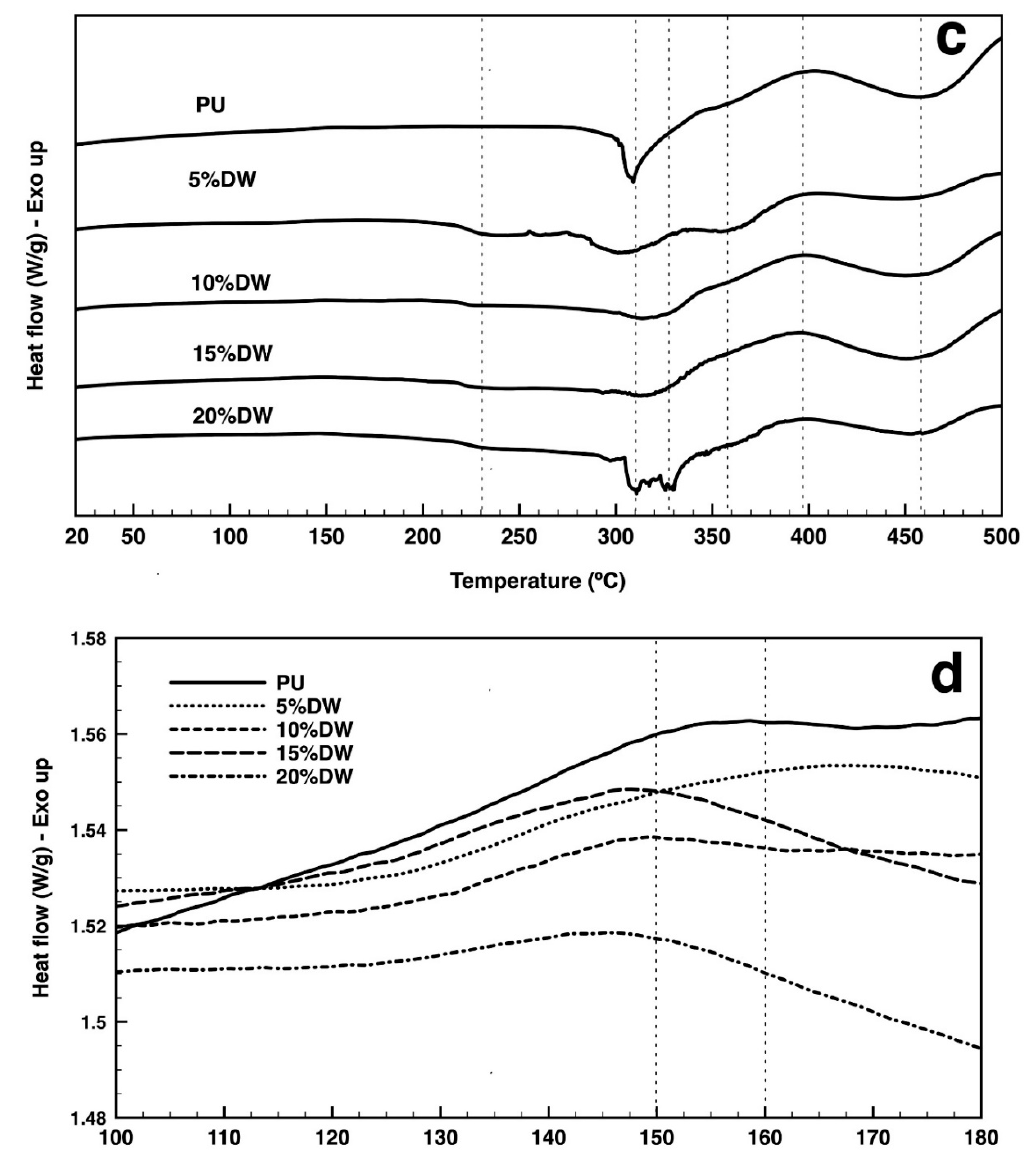
Figure 6. DSC thermogram of the pristine PU and the eco-composites containing 5, 10, 15, and 20% of dog wool microparticles collected at a heating rate of 10 ◦ C / min in a nitrogen atmosphere. ( a ) The first heating cycle between 20 and 120 ◦ C, ( b ) the first cooling cycle between 120 and 20 ◦ C, ( c ) the second heating cycle between 20 and 500 ◦ C. ( d ) Detail of the second heating cycle between 100 and 180 ◦ C showing the T g .